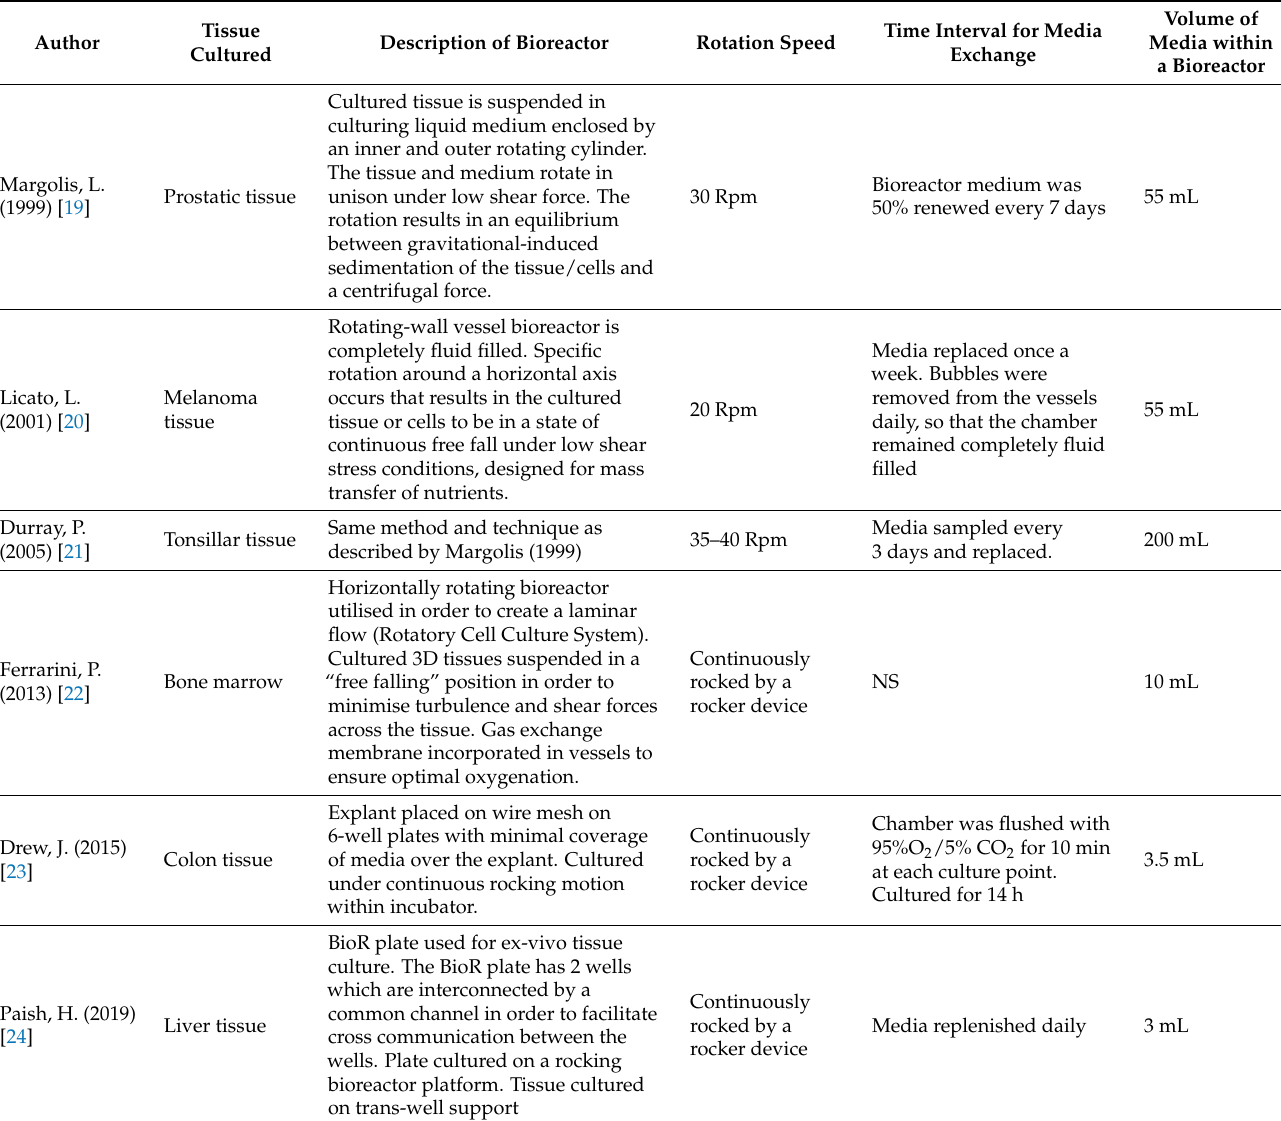
Table 2. Characteristics of studies utilising a rotational bioreactor with physiological flow